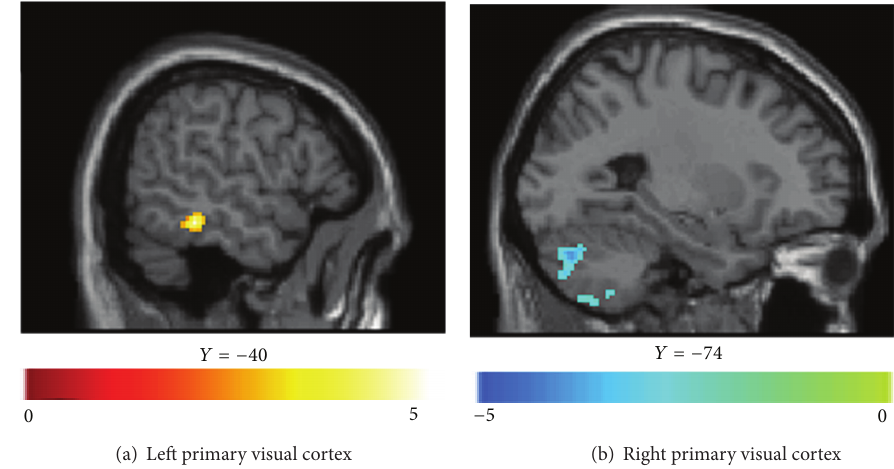
Figure 4: Alterations in functional connectivity with the left primary visual cortex (a) and the right primary visual cortex (b) between anisometropic amblyopic subjects and mixed amblyopic individuals are shown ( 𝑃 < 0.01 , 130 voxels, AlphaSim corrected, 𝑃 details of the regions can be found in Table